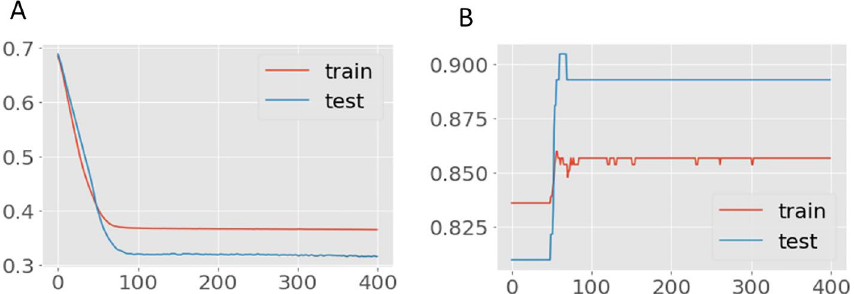
Figure 5. Learning curves of Model 2 (mRSS and WHO-FC ≥ III), ( a ) Training and validation loss, ( b ) the model accuracy in training and validation. Title = ( a ) Model loss ( b ) Model accuracy. X-axis = ( a ) Loss ( b ) Accuracy. Y-axis = ( a ) number of epochs ( b ) number of epochs.